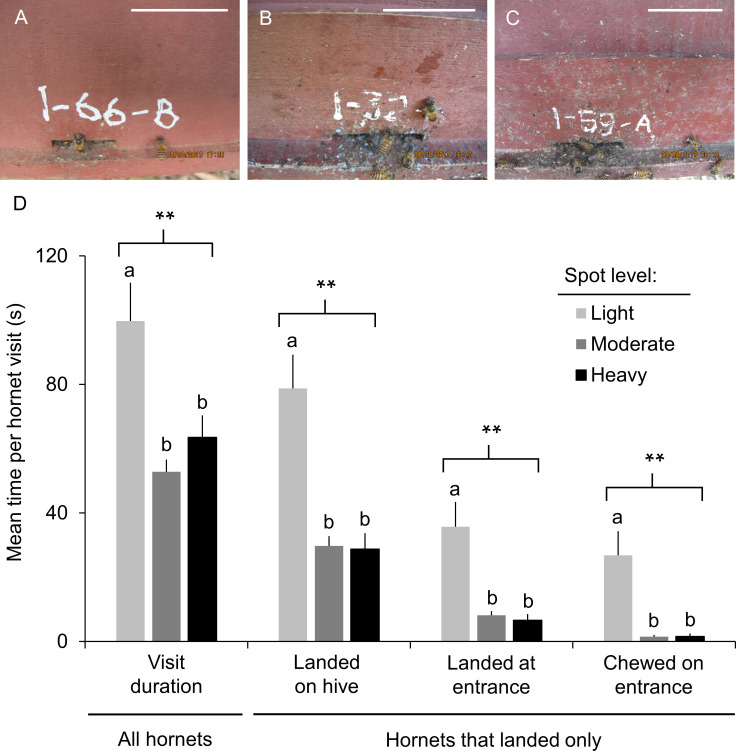
Vespa soror workers spent less time trying to breach nest entrances as spotting increased.Images show the spread of spots around entrances for colonies that ranked at the midpoint of each of the three spotting categories: (A) light spotting (median 42, range 8–99 spots per hive front); (B) moderate spotting (median 275, range 107–495 spots per hive front); (C) heavy spotting (median 636, range 504–1,523 spots per hive front). White scale bars = 5 cm. (D) Mean time (± SEM) per hornet spent visiting a colony and, for hornets that landed on hives, time spent performing nest-breach behaviors (i.e., landed anywhere on the hive, landed at the entrance specifically, chewed on the entrance margins). Visit duration was calculated for all hornets (left: light = 81 visits; moderate = 141 visits; heavy = 54 visits). Time spent trying to breach nests was calculated only for hornets that landed on hives (right: light = 72 visits; moderate = 115 visits; heavy = 46 visits). Data were obtained from the videos used to produce Table 2 (see legend). Asterisks indicate a significant difference among groups identified within brackets (** p < 0.0001); letters indicate differences among treatment means).